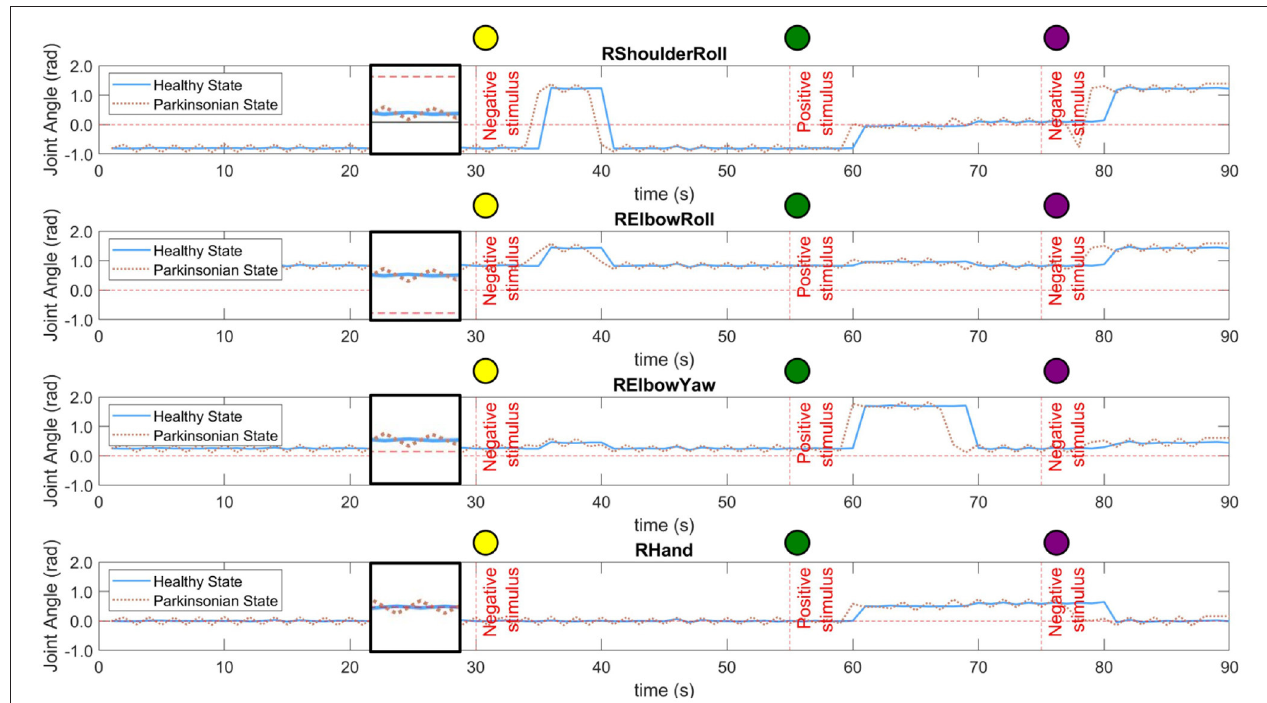
FIGURE 10 | Dynamics of four different joints of the right arm of the robot during the performance of the task. Both conditions of the computational model were tested, healthy and parkinsonian . The oscillation under the parkinsonian condition indicates the production of the tremor symptom in the robot’s arm. A small window was created in between 20 and 30 s of each graphic to zoom in on both signals.